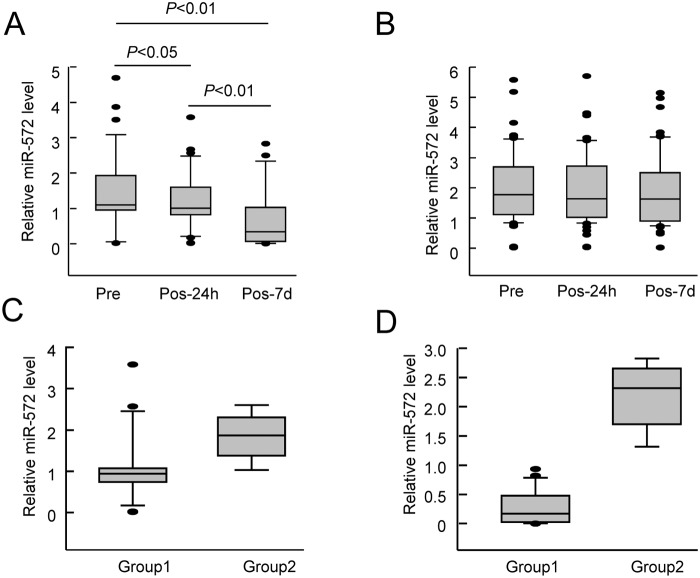
miR-572 expression in the peripheral blood of clinical patients.A. Real-time quantitative PCR detection of the miR-572 expression levels in the peripheral blood of POCD patients (n = 38) before surgery (Pre), 24 h after surgery (Pos-24h), and 7 days after surgery (Pos-7d). B. Real-time quantitative PCR detection of the miR-572 expression levels in the peripheral blood of non-POCD patients (n = 62) before surgery (Pre), 24 h after surgery (Pos-24h), and 7 days after surgery (Pos-7d). C. Real-time quantitative PCR detection of the miR-572 expression levels in the peripheral blood of POCD patients whose cognitive function was recovered 3 months after surgery (n = 29, Group1) and whose cognitive function was not recovered (n = 9, Group2) 24 h after surgery. D. Real-time quantitative PCR detection of the miR-572 expression levels in the peripheral blood of POCD patients whose cognitive function was recovered 3 months after surgery (n = 29, Group1) and whose cognitive function was not recovered (n = 9, Group2) 7 days after surgery.